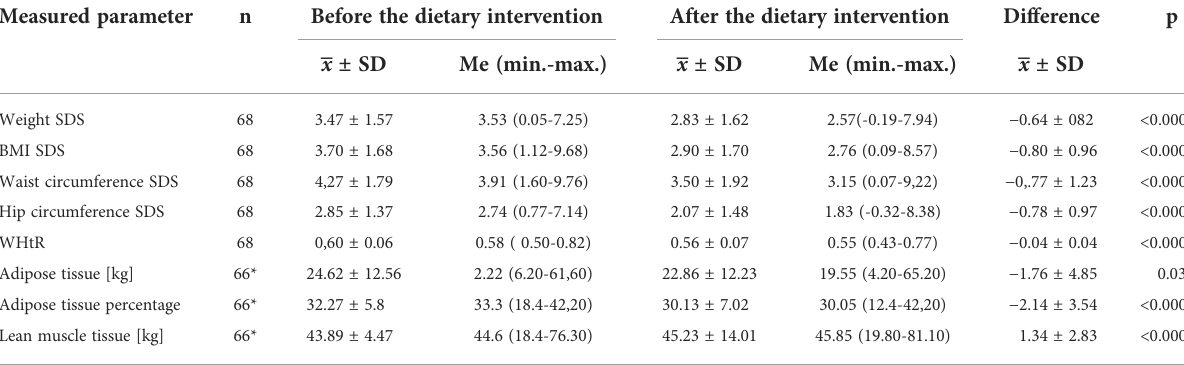
TABLE 1 Changes in measured anthropometric parameters in the studied children before and after the dietary intervention. Measured